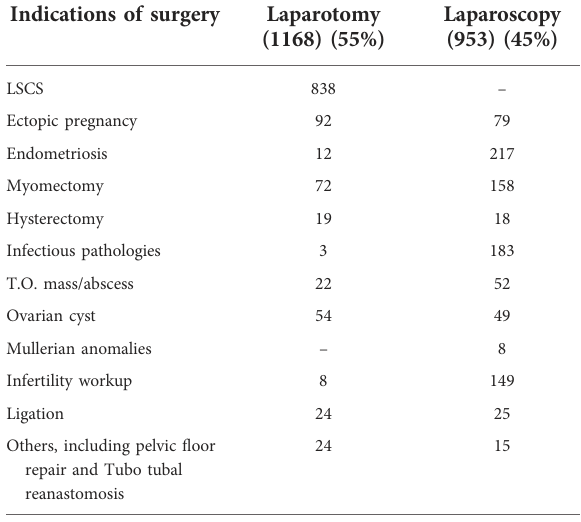
TABLE 2 Distribution of previous surgery cases according to body mass index.